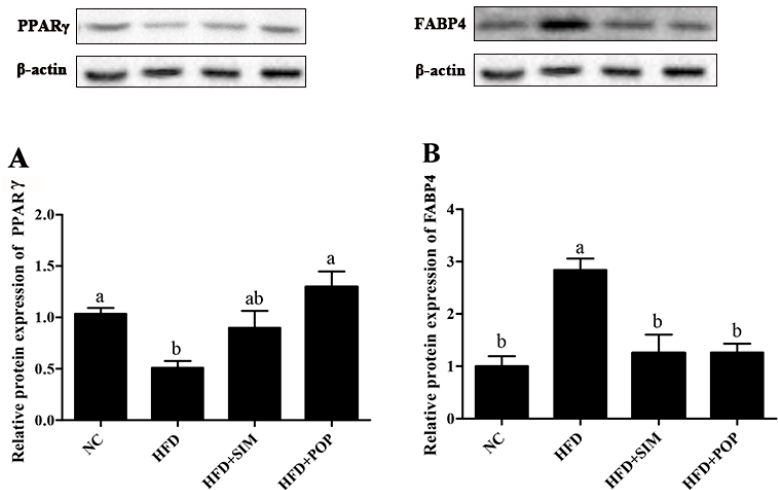
Figure 4. Western blotting analysis of PPAR γ and FABP4 relative expression in HFD-fed rats. ( A ) PPAR γ protein expression, ( B ) FABP4 protein expression. NC = normal control, HFD = high-fat diet, HFD + SIM = HFD with simvastatin (1.8 mg/kg), HFD + POP = HFD with P . odoratum polysaccharides (400 mg/kg). All data are presented as means ± SEM. a,b Mean values not sharing a common superscript were significantly different among the groups ( n = 5 for each) ( p < 0.05).